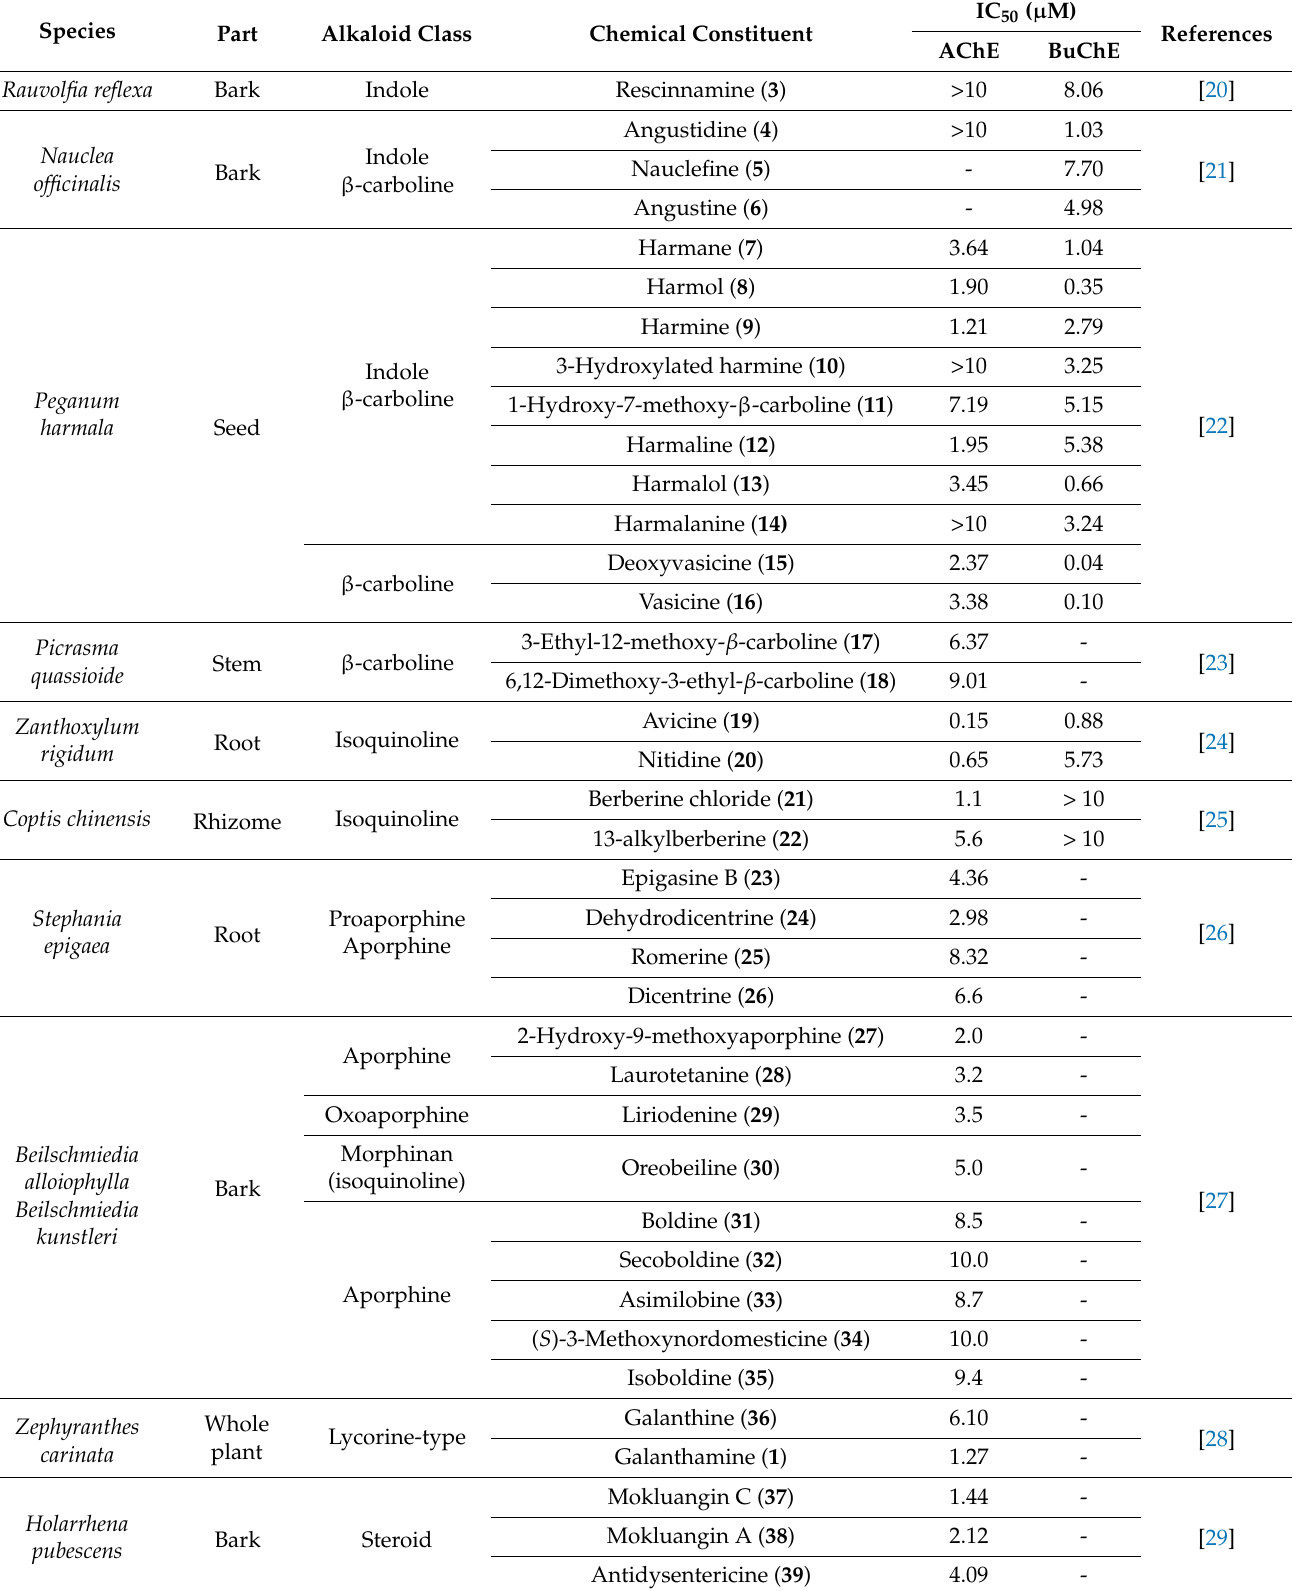
Table 1. Alkaloids from different species and respective IC 50 towards AChE and